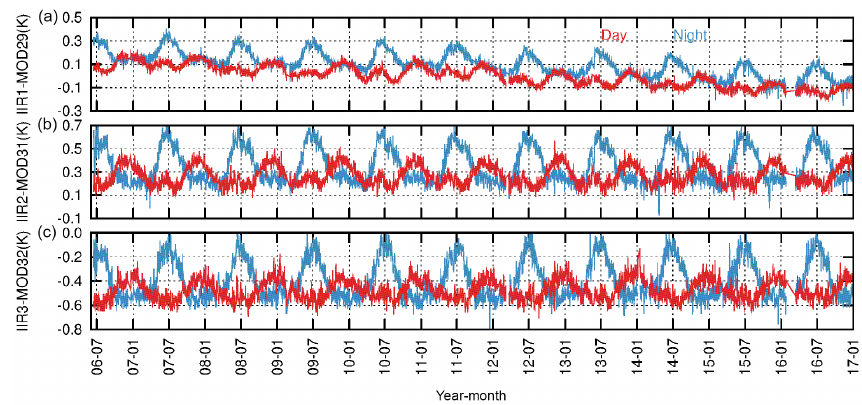
Figure 4. Time series of IIR Version 1–MODIS C5 daily average BTDs over oceans for IIR1–MODIS29 (a) , IIR2–MODIS31 (b) , and IIR3–MODIS32 (c) . Latitude range: 30–60 ◦ N. Temperature range: 280–290K. Unexpected seasonal differences are seen between nighttime (blue) and daytime (red) BTDs. Adapted from Garnier et al. (2017).